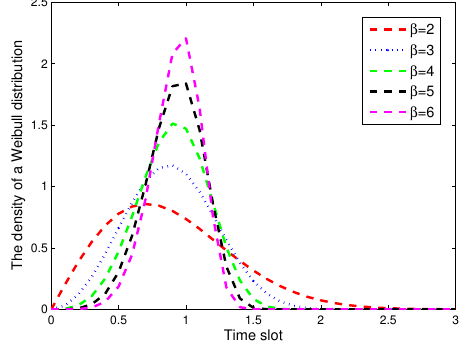
Figure 3. The density of the Weibull distribution.